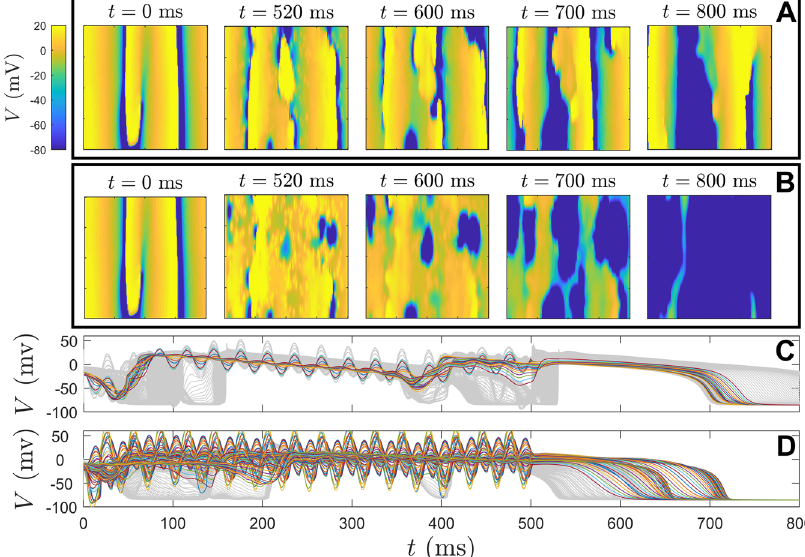
Figure 9. Elimination of spiral waves on a 2-dimensional domain with an alternating current electric field. In panel A (resp., B) a 33 Hz alternating electric field of 1.76 V/cm (resp., 5.29 V/cm) lasting 500 ms is applied to (14). Initial conditions in both simulations are identical with a single spiral wave present at t = 0. Panels C and D show 200 individual cell voltage traces corresponding to simulations from panels A and B, respectively. These cells are taken from the vertical centerline of the square domain. Note that the cells closest to the virtual electrodes are influenced most strongly by the applied extracellular voltage gradient. In panels C and D, cells that remain depolarized during the entire application of the alternating electric field are plotted in color. As expected, larger magnitude voltage fields result in increased transmembrane current flow near the tissue heterogeneities. The number of cells that experience conduction block (i.e., with a stabilized depolarized state) increases as the magnitude of the extracellular stimulation increases. This effectively splits the larger domain into smaller subdomains so that the spiral can be absorbed.